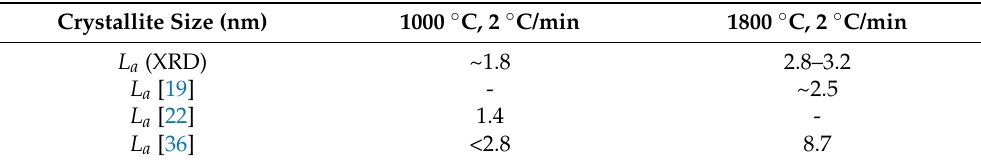
Table 6. L a values obtained directly from XRD (top line), and then from the I D / I G obtained by Raman spectroscopy using various correlations available in the